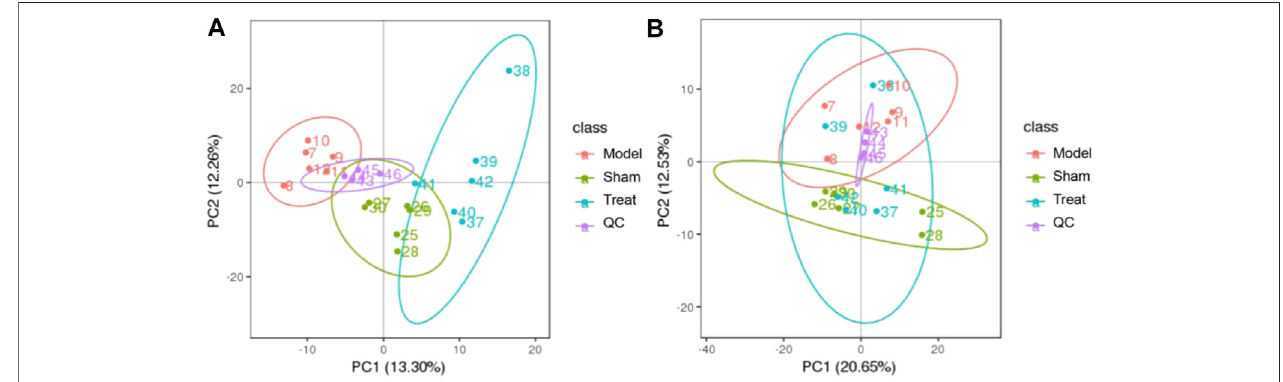
FIGURE5 | PLS-DA scoreplots ofthe plasma samples from Sham group, Model group inpositivemode (A) and negativemode (B) . Thecorrespondingvalidation plots based on 200 times permutation tests of the PLS-DA models in positive mode (A) and negative mode (B) . The ellipse represents the con fi dence interval of 95%.